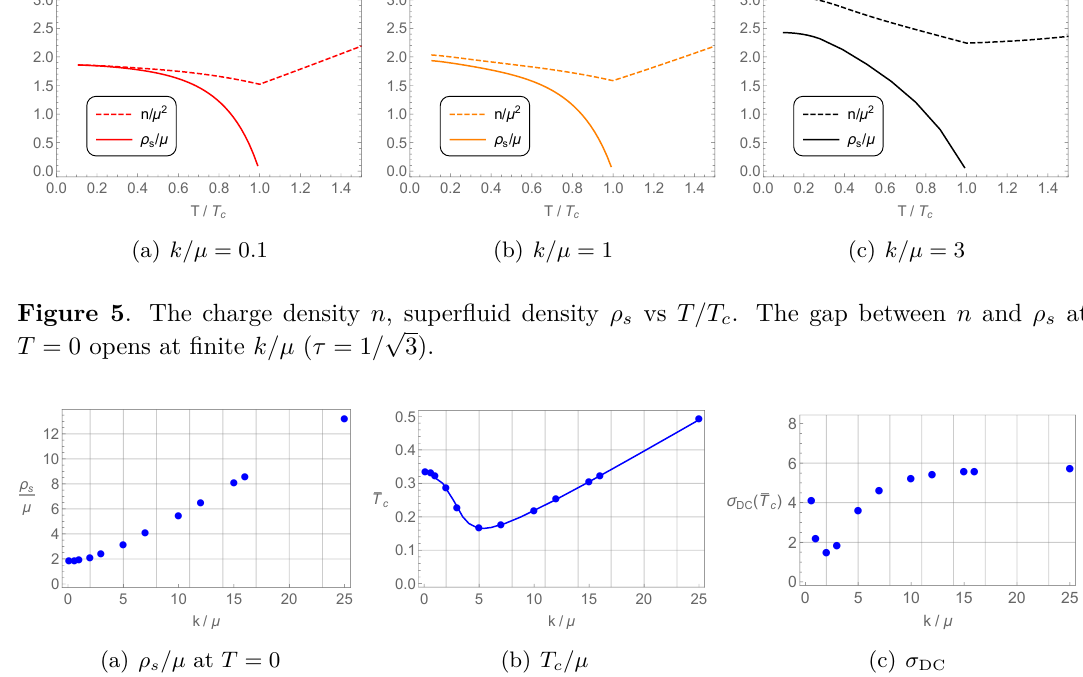
Figure 6 . ρ s , T c , and σ DC ( T c ) for τ = 1 / line corresponds to the one in figure